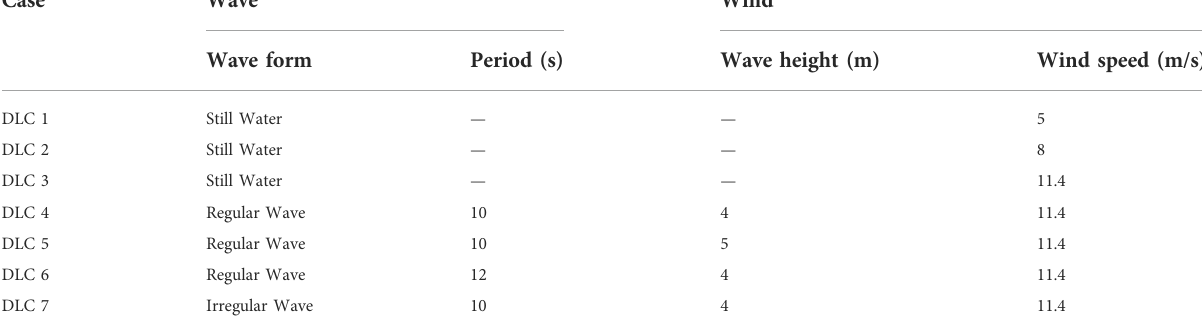
TABLE 3 The list of the